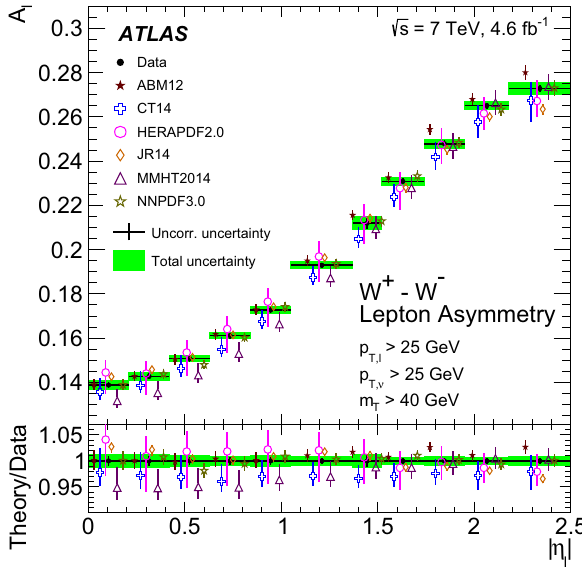
Fig. 22 Lepton charge asymmetry A (cid:3) in W → (cid:3)ν production as a function of the lepton pseudorapidity | η (cid:3) | . Predictions computed at NNLO QCD with NLO EW corrections using various PDF sets ( open symbols ) are compared to the data ( full points ). The ratio of theoreti- cal predictions to the data is also shown. The predictions are displaced within each bin for better visibility. The theory uncertainty corresponds to the quadratic sum of the PDF uncertainty and the statistical uncer- tainty of the